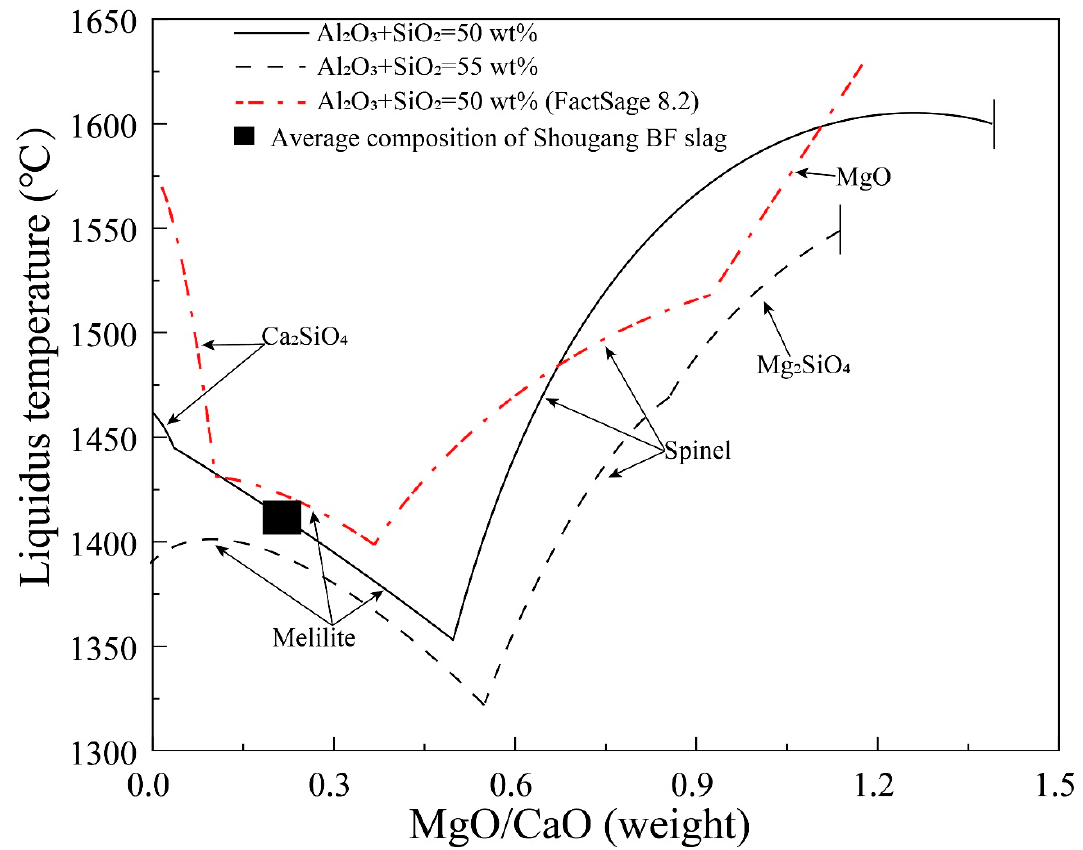
Figure 6. Liquidus temperature as a function of MgO/CaO in liquids at fixed (Al 2 O 3 +SiO 2 ) of 50 and 55 wt% in the CaO-MgO-SiO 2 -Al 2 O 3 system with Al 2 O 3 /SiO 2 weight ratio of